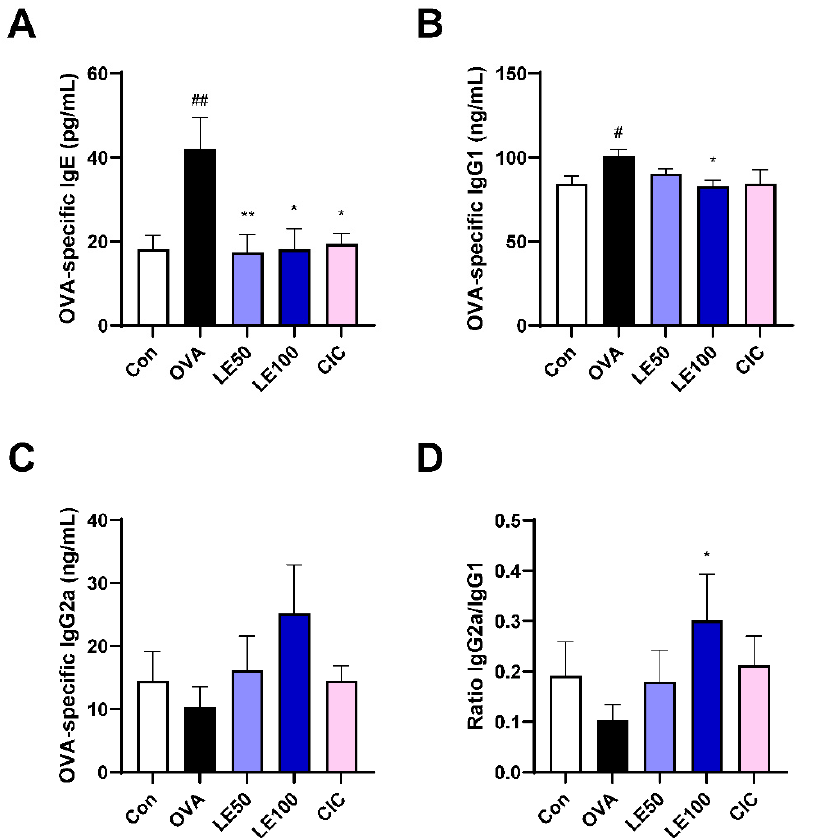
Figure 3. The effects of LE on OVA-specific IgE, IgG1, and IgG2a in the serum of OVA-induced AR mice. Serum measurement of ( A ) OVA-specific IgE, ( B ) OVA-specific IgG1, and ( C ) OVA-specific IgG2a. ( D ) The IgG2a:IgG1 ratio was calculated for each mouse. The average ratio for each group is shown. All results are represented as the mean ± SEM ( n = 10 per group). Significant differences at # p < 0.05, ## p < 0.01, versus the control group. * p < 0.05, ** p < 0.01 versus the OVA group.